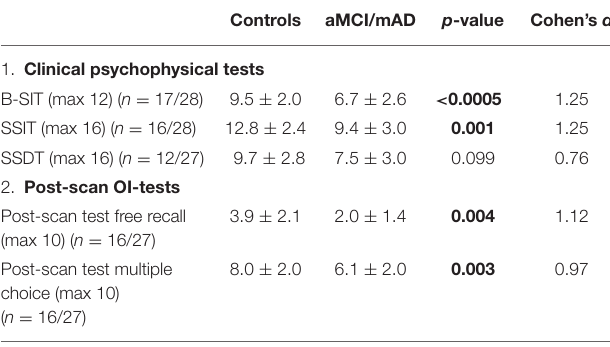
TABLE 3 | Olfactory tests scores (mean ± SD) for the control group compared to aMCI/mAD group. Controls aMCI/mAD p